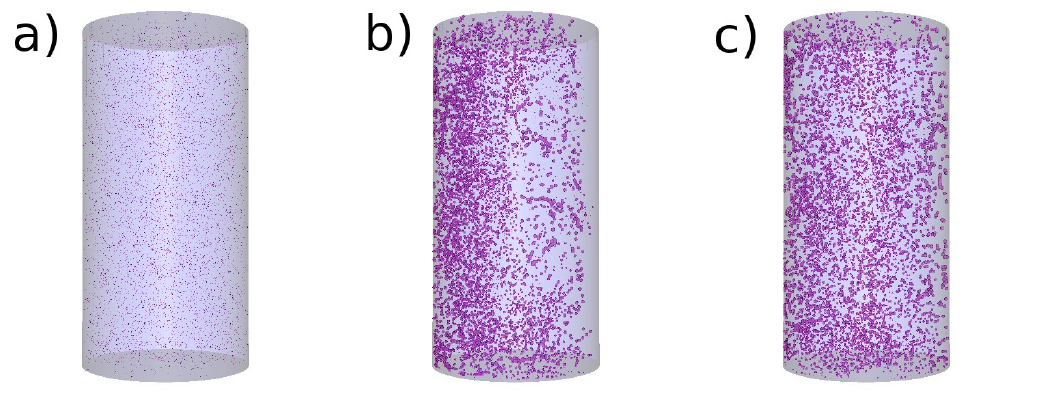
Figure 2. Bubbles location in the domain for three time instants: ( a ) time = 500—phenomenon beginning; ( b ) time = 520—before the reversal; ( c ) time = 530—after the reversal. The bubbles size is considered at each time.